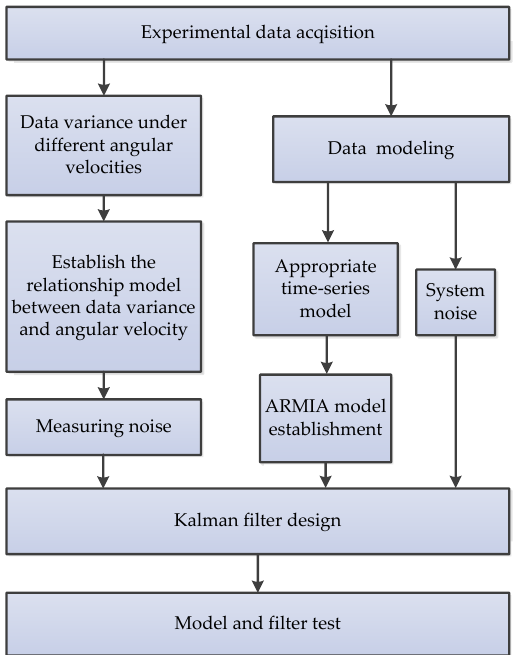
Figure 23. The adaptive filtering method based on the dynamic variance model [86].